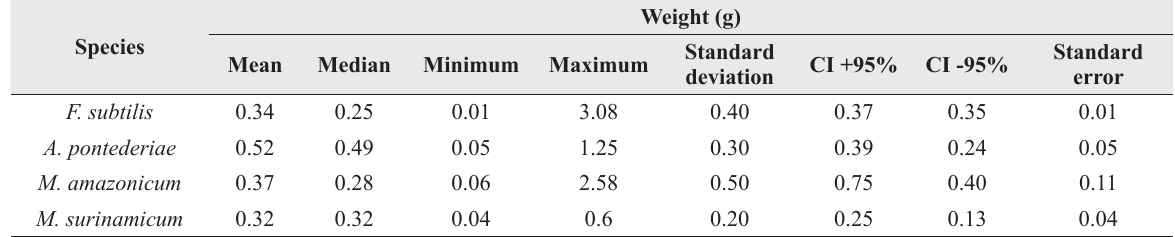
Descriptive statistic of weight (g) of shrimps from Guarás Island, Curuçá, State of Pará, Brazilian Amazon. CI = Confidence Interval.